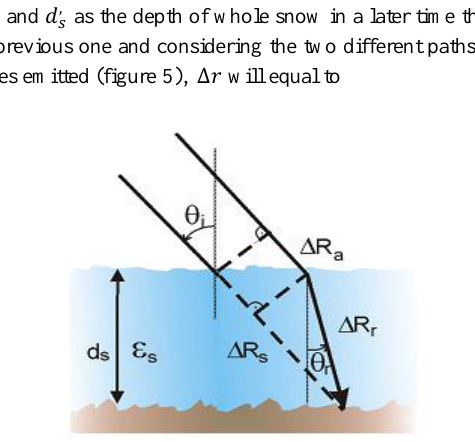
Figure 5 . Propagation path of microwaves (Nagler, 2003)